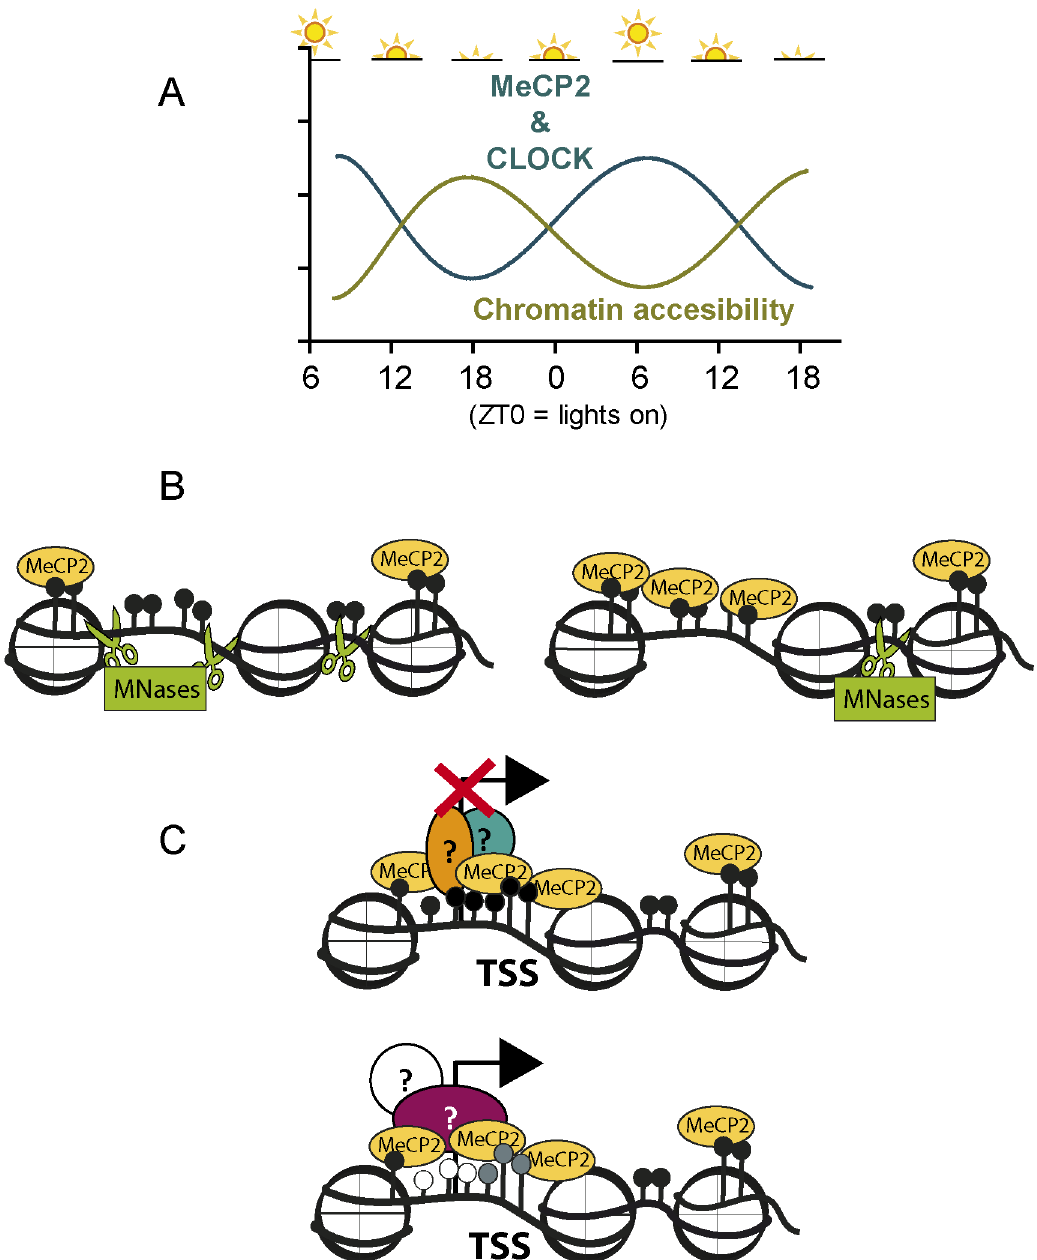
Fig 4. Cartoon representation of the transitions observed during the mouse circadian cycle. (A) The circadian variation of CLOCK and MeCP2 are accompanied by changes in the overall accessibility of brain chromatin to Mnase digestion. (B) Schematic representation of the MeCP2 changes observed during the circadian cycle. The overall increase in the MeCP2 level results in changes in its binding to the chromatin substrate, resulting in global changes in micrococcal nuclease accessibility (green scissors). (C) Additional MeCP2 binding to 5-hydroxymethylcytosines or 5-methylcytosines of certain chromatin domains and its possible association with different protein partners, results in the enhancement of its dual transcriptional activity, leading to either activation or repression of gene expression. In this representation, nucleosomes are in white, DNA is indicated as a black line, CpG dinucleotides are represented as lollipop structures black colored when methylated, grey when hydroximethylated and white when unmodified; MeCP2 partners are depicted as ovals or circles with question marks.